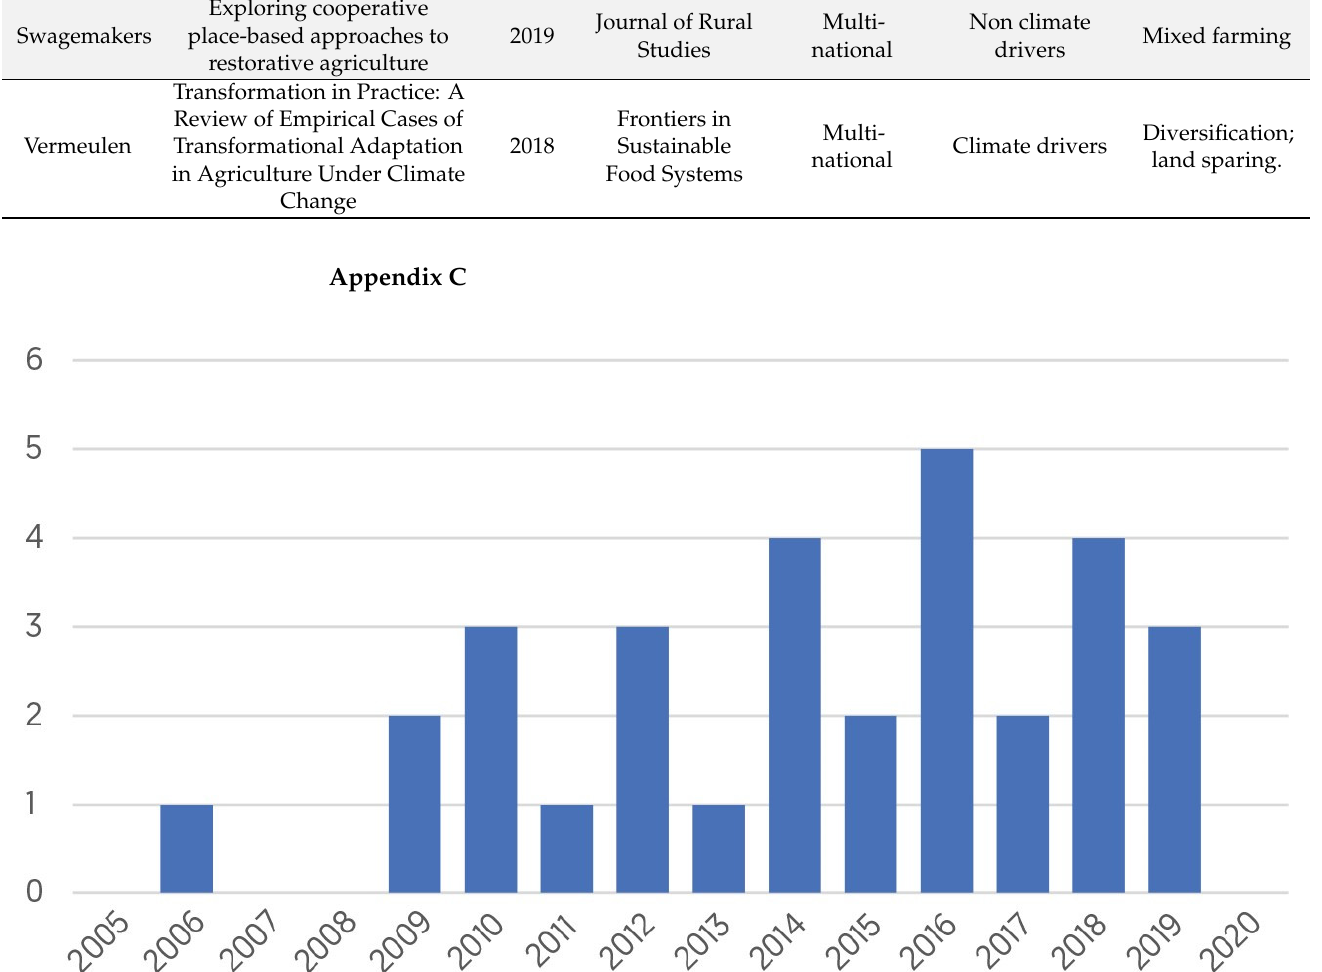
Figure A2. Publications per year.